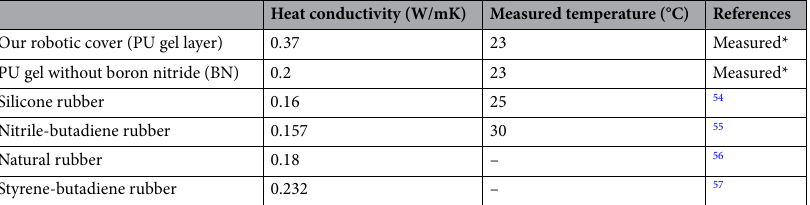
Heat conductivity (W/mK) Measured temperature (°C) References Our robotic cover (PU gel layer)